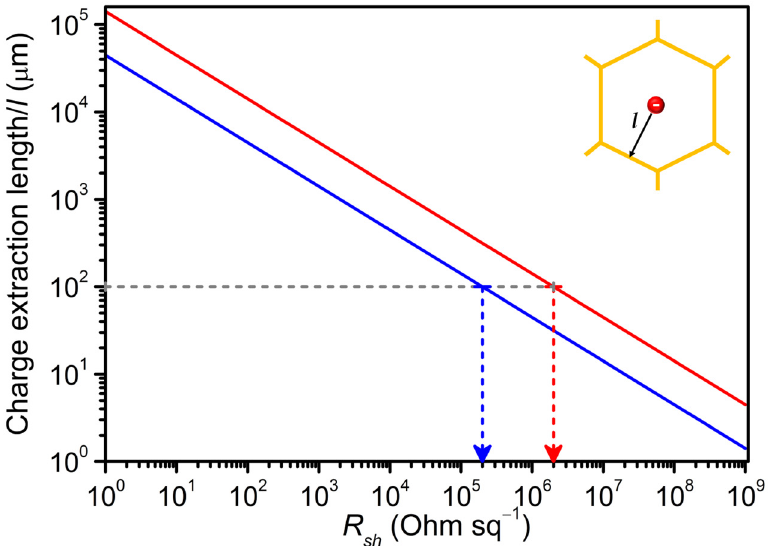
Figure 1. Relation between the sheet resistance ( R sh ) of the filler layer and charge carrier extraction length ( l ) from a void space in the metal network electrode as shown in the inset scheme. The plots are derived by assuming J sc of 20 mA/cm 2 and Δ V of 100 mV (red) or 10 mV (blue) in a perovskite solar cell. The horizontal grey line intercepting red and blue lines notifies the required R sh value of the filler to collect the charges from 100 μ m distance with the voltage loss of 100 and 10 mV, respectively.